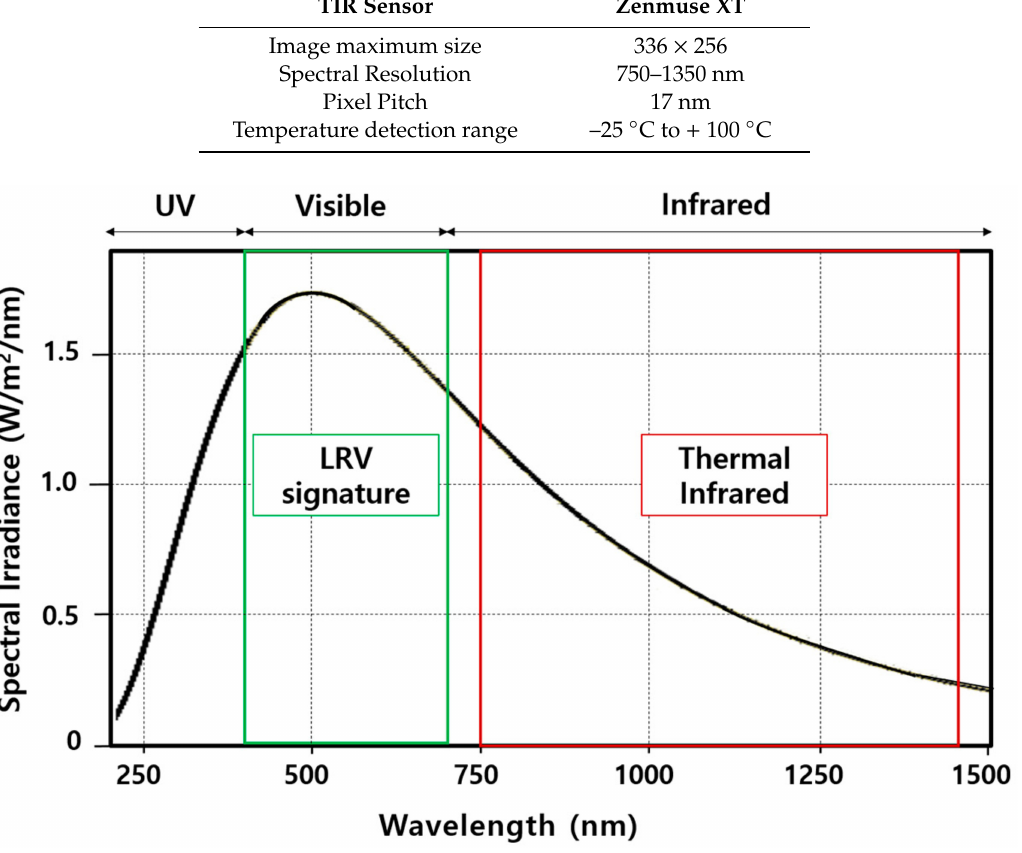
Figure 3. Solar irradiance spectrum di ff erentiated between LRV and thermal infrared (LRV: 400–700 nm, thermal infrared: 750–1450 nm). The solar energy intensity varies over wavelengths from approximately 250 to 1500 nm, modified from